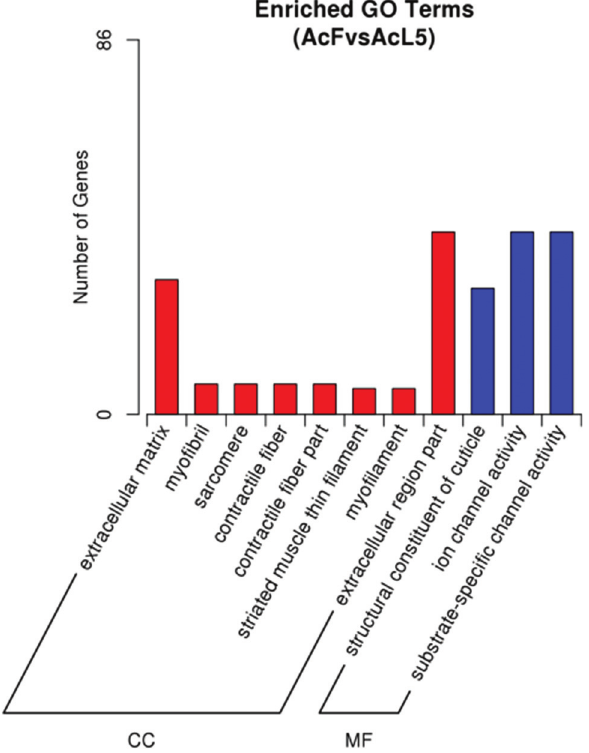
Figure 4 - KEGG classifications of unigenes from the P transcriptome. (A) Cellular processes, (B) Environmental information processing, (C) Genetic information processing, (D) Metabolism and (E) Organismal systems.